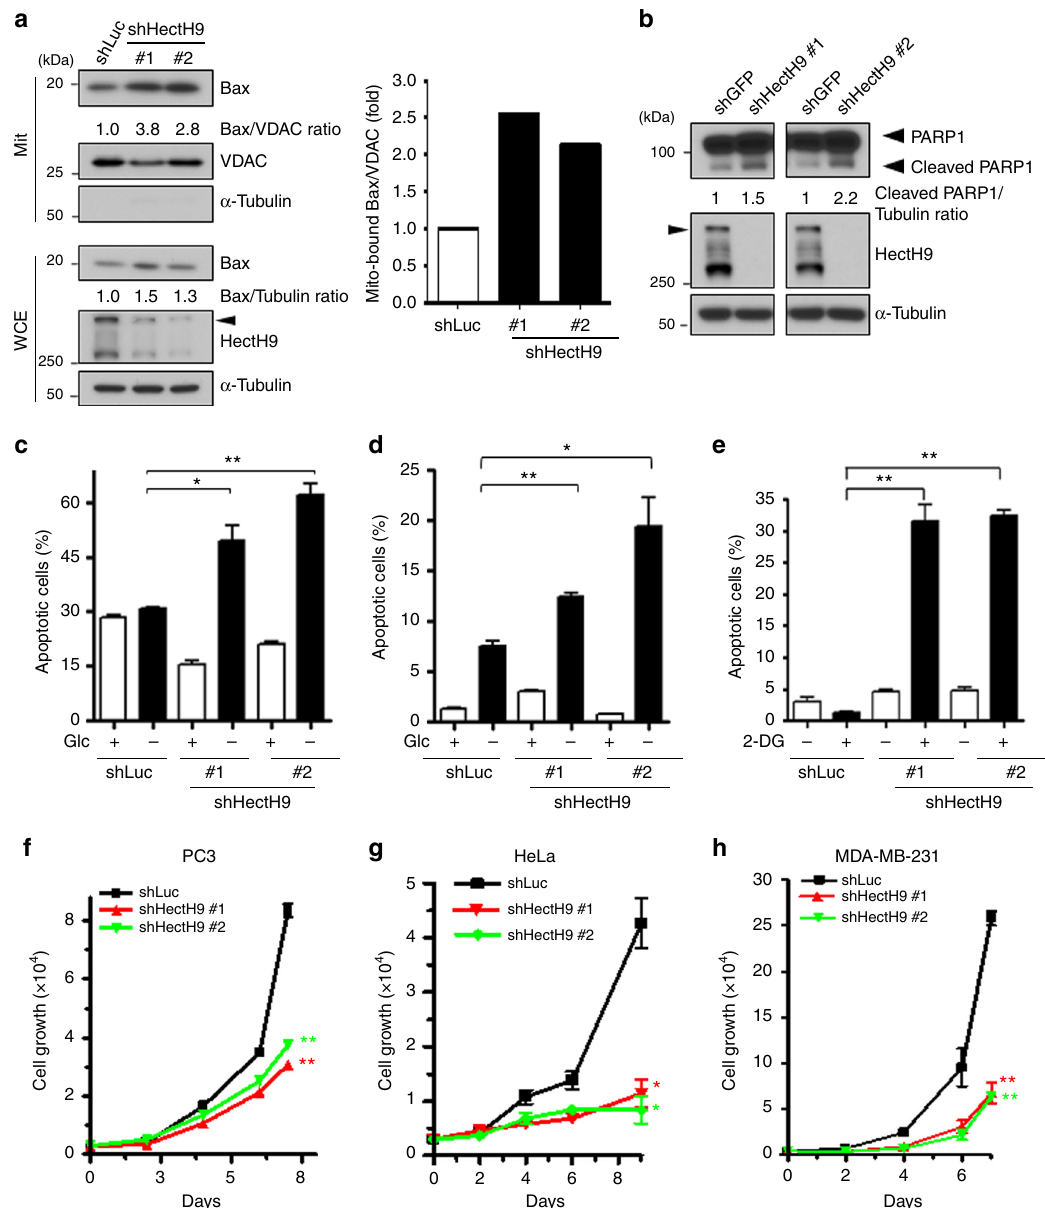
Fig. 4 HectH9 de fi ciency triggers cellular apoptosis under glucose deprivation. a Biochemical fractionation assay for Bax mitochondrial localization in PC-3 cells with Luciferase or HectH9 knockdown is shown in the left panel. VDAC and α -Tubulin were used as markers for mitochondrial and cytosolic fractions, respectively. The relative intensity of mitochondrial-bound Bax quanti fi ed with ImageJ software and normalized to mitochondrial VDAC levels in the corresponding cells is shown in the right. The experiment was performed twice. b IB analysis of cleaved PARP1 expression in PC-3 cells with GFP or HectH9 knockdown. The relative intensity of cleaved PARP1 expression was quanti fi ed with ImageJ software and normalized to α -Tubulin expression. The experiment was performed twice. c and d The percentage of apoptotic cells was determined by annexin V and propidium iodide (PI) staining in Luciferase- knockdown and HectH9-knockdown PC-3 cells ( c ) or MDA-MB-231 cells ( d ) cultured in media with or without glucose (Glc) ( n = 3). e The percentage of apoptotic cells was determined by annexin V and PI staining in Luciferase-knockdown and HectH9-knockdown PC-3 cells in the presence of vehicle or 2-DG ( n = 3). f – h Cell growth assays in PC-3 ( f ), HeLa ( g ) and MDA-MB-231 ( h ) cells with Luciferase or HectH9 knockdown ( n = 3). Results in c – h are presented as mean value ± SD; * p < 0.05, ** p < 0.01, by Student ’ s t -test. These experiments were performed three times in triplicates. Immunoblots